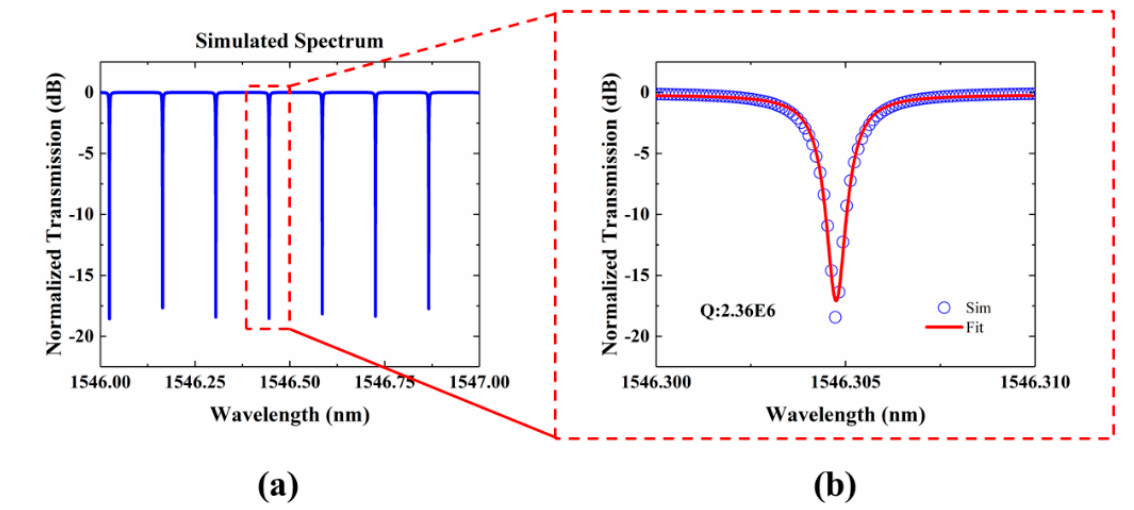
Figure 6. ( a ) Part of the simulated transmission spectrum. ( b ) One peak of simulated transmission spectrum with Lorentzian fitting.